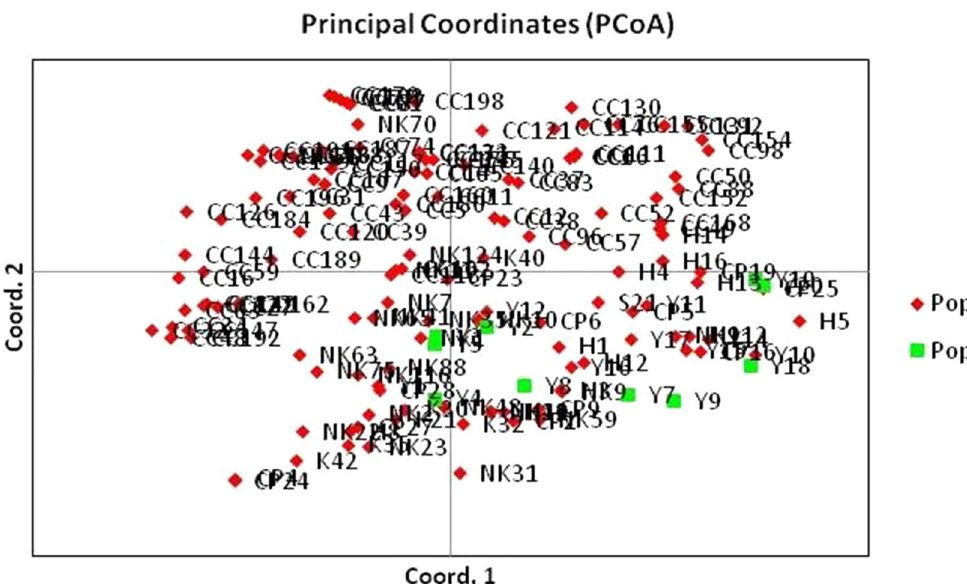
Figure 3. PCoA showing clustering of different chickpea genotypes into different co-ordinates. The genotypes highlighted with different colors (black versus green) shows two different